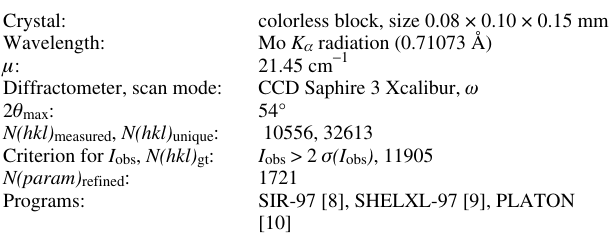
Table 1. Data collection and